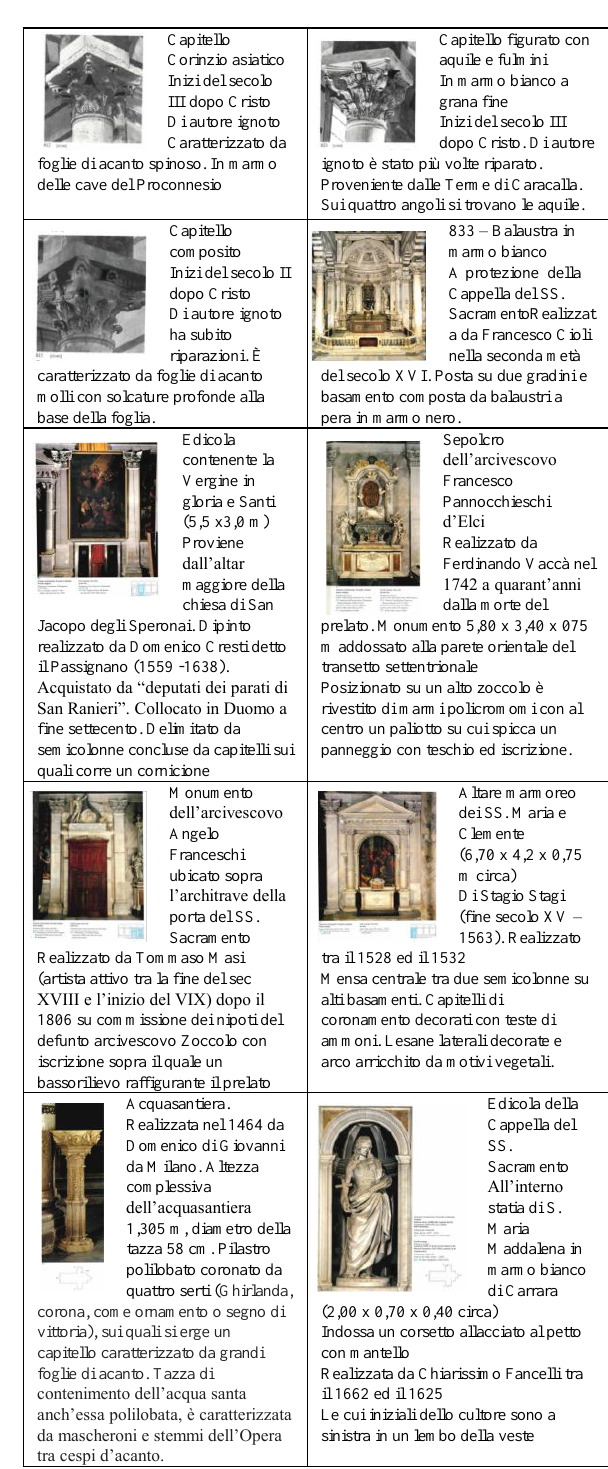
Figure 4. Information sheets of the internal parts of the